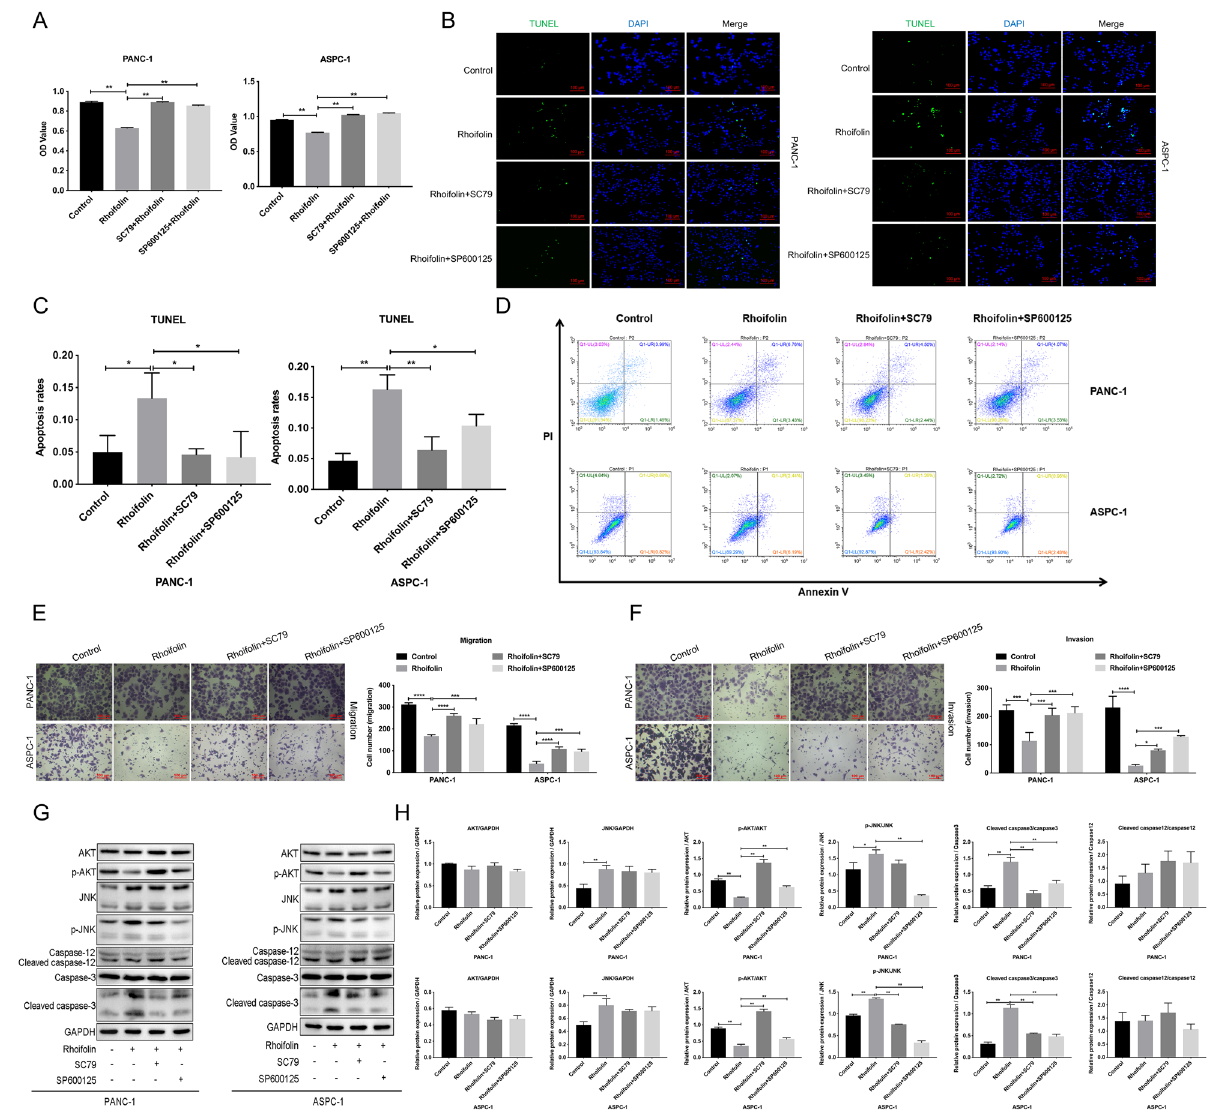
Figure 6. Rhoifolin suppressed proliferation, migration and invasion, and accelerated apoptosis by JNK and AKT pathways in pancreatic cancer cells. PANC-1 and ASPC-1 cells were dealt with rhoifolin, SC79, or/and SP600125, respectively. (A) Cell proliferation analysis of PANC-1 and ASPC-1 cells after processing. (B) Cell apoptosis was tested with TUNEL staining. (C) The rate of TUNEL positive cells was calculated. (D) Flow cytometry was utilized to monitor cell apoptosis. ( E,F ) The migrated and invaded cells were assessed with Transwell. ( G ) Western blotting analysis of AKT, p-AKT, JNK, p-JNK and apoptosis-related proteins in the processed cells. ( H ) Relative quantitative analysis of the western blotting